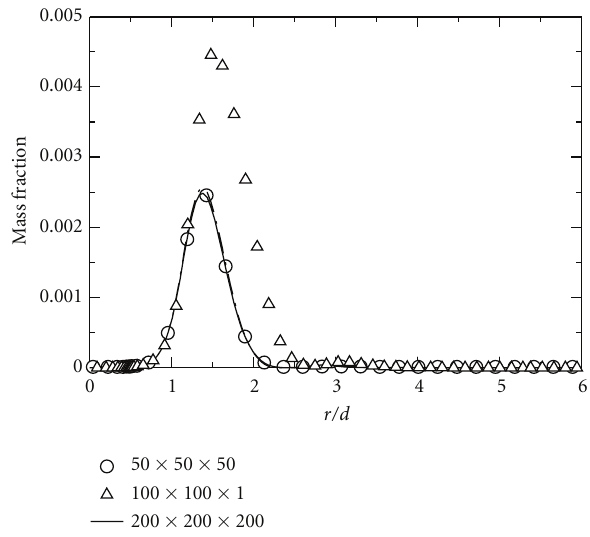
Figure 24: Radial mass fraction of OH at x/d = 10 predicted by di ff erent table sizes.